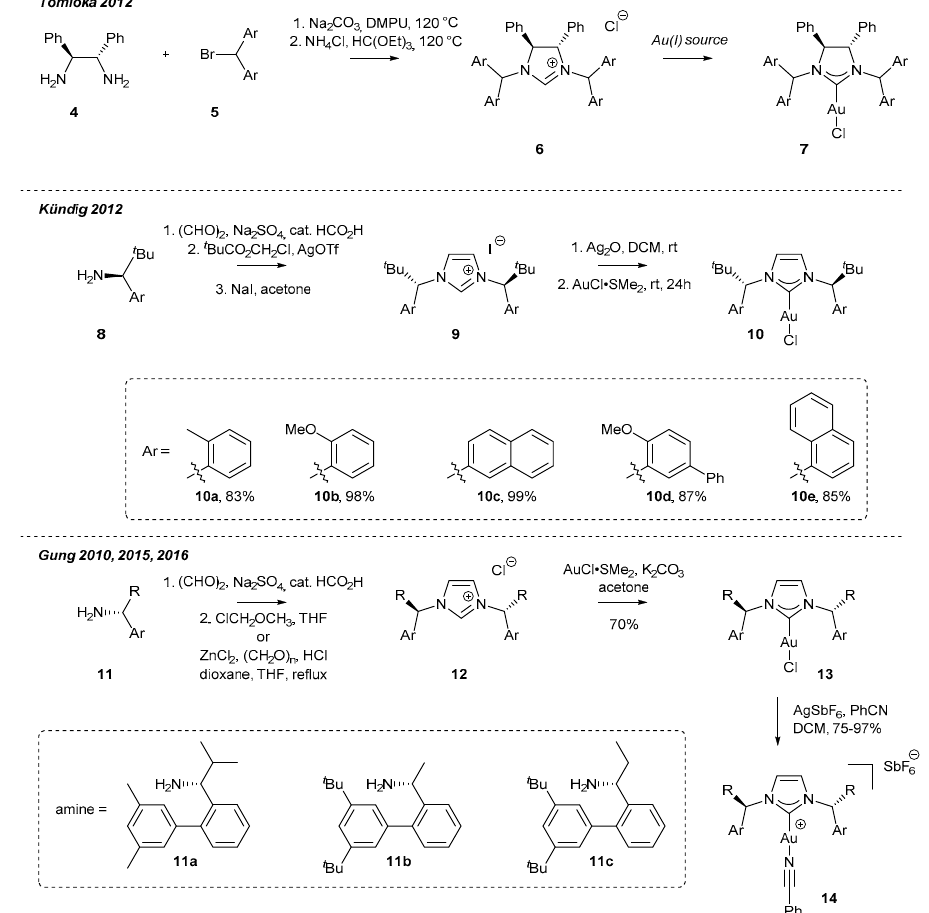
Scheme 2. The synthesis of C 2 -symmetric gold(I) complexes from chiral